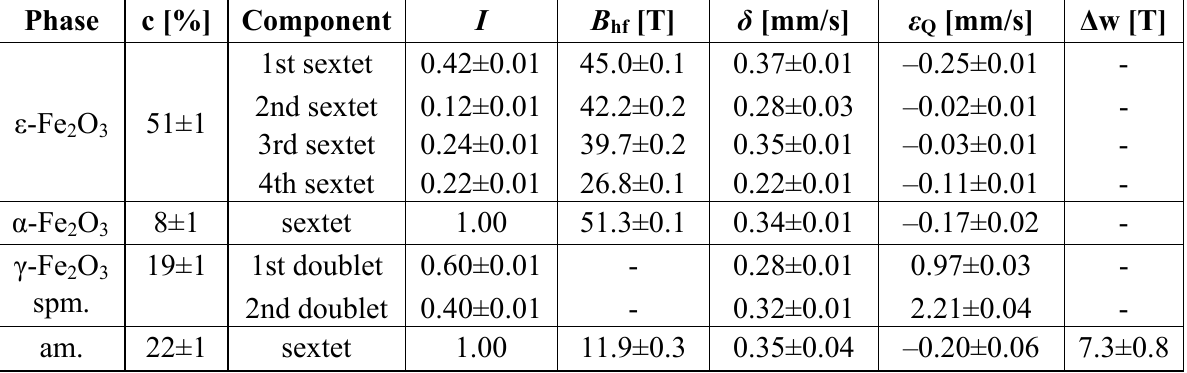
O /SiO 2 3 2 – quadrupole splitting, Δ w Q